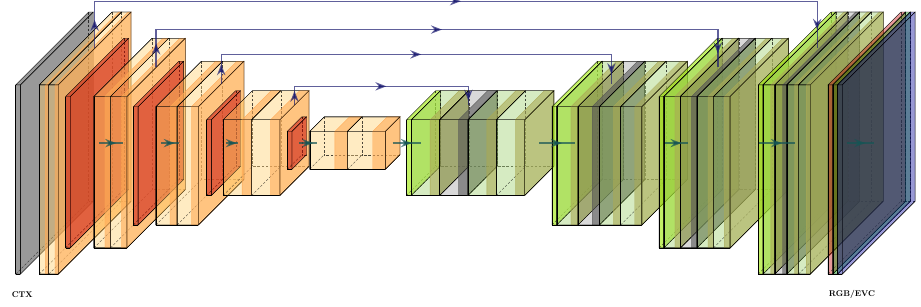
Figure 1. Illustration of a typical U-Net-style [34] neural network architecture used in this work. Each neural network used in this work has a related structure. The network consists of two parts: an encoder (orange) and a decoder (green). The flow of the signal through the network is indicated by arrows. At the end, the neural network predicts pixel-wise bands (e.g., red, green, and blue) from the monochromatic input image